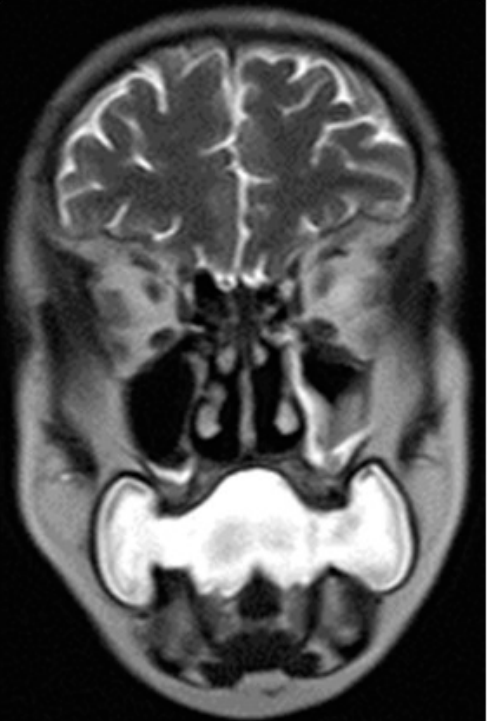
Figure 17. Water distension of oral vestibule. The presence of water in the oral vestibule enables a better delineation and distinction of the buccal and gingival mucosa, allowing a better analysis of possible abnormalities.